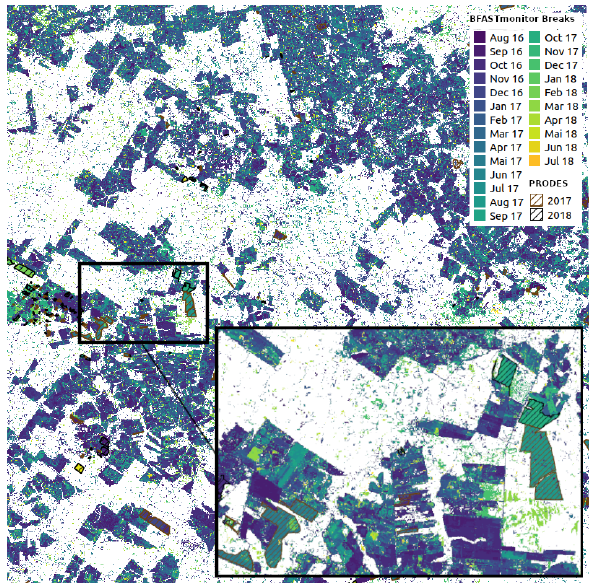
Figure 3. PRODES and BFAST Break Detection with SAVI Index for 2017-2018 at tile 21LYH.